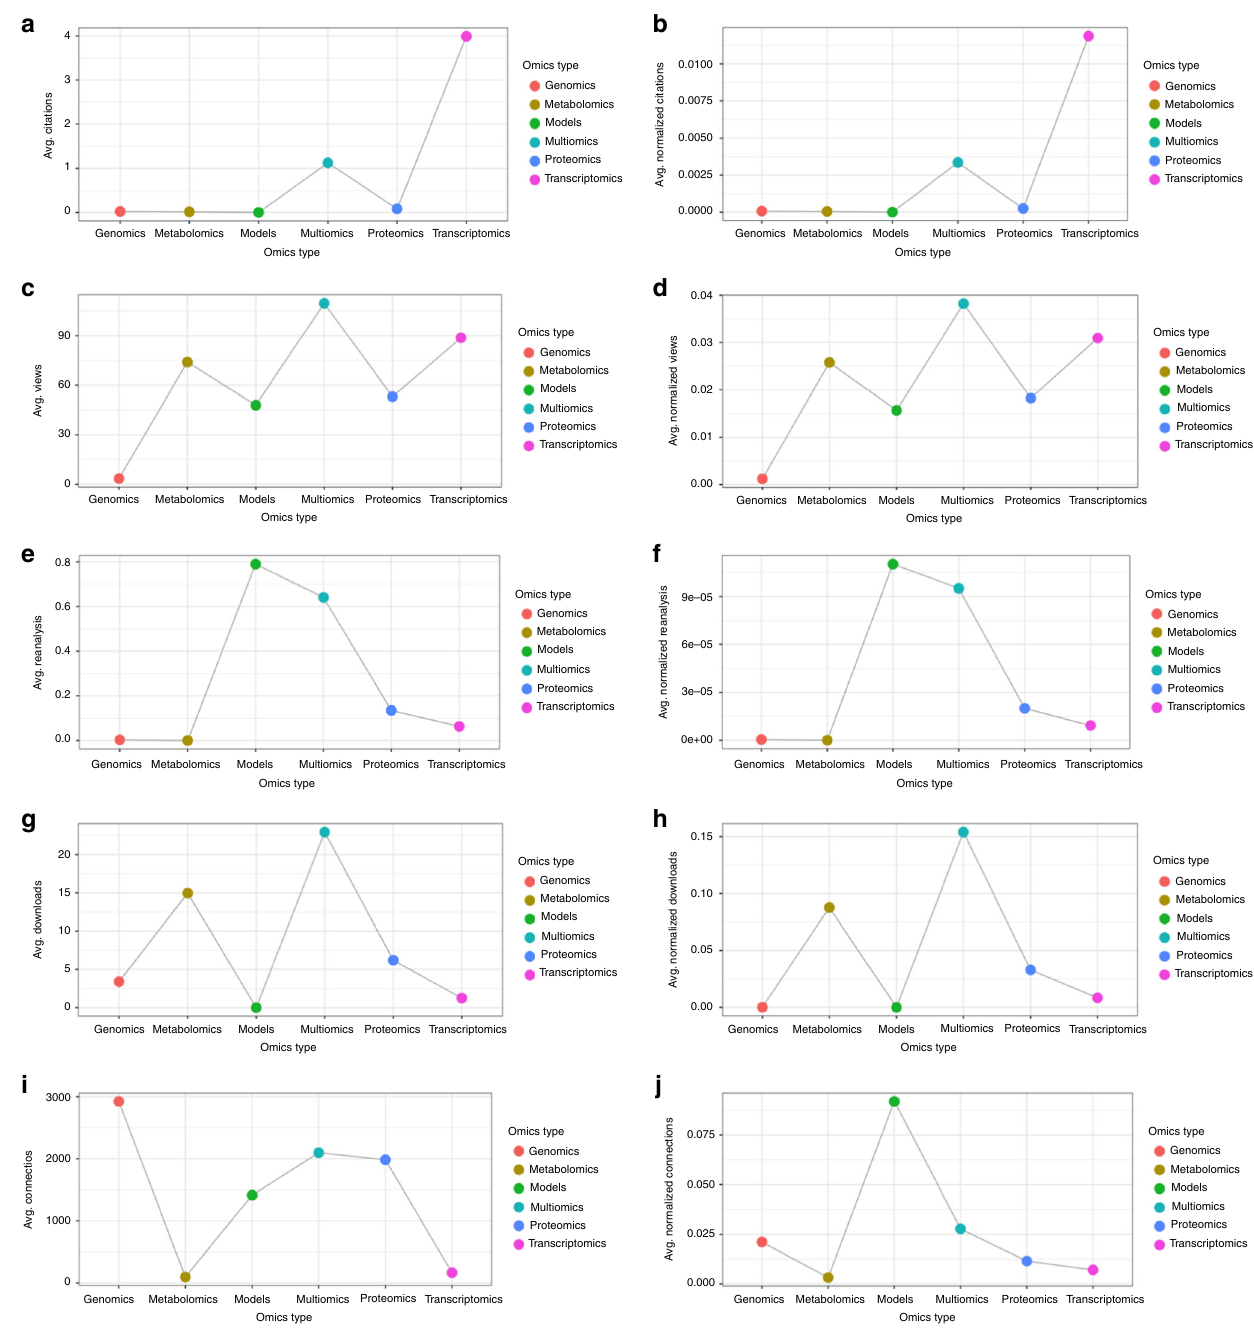
Fig. 4 Average distribution of each metric ( citations, views, reanalysis, downloads and connections ) by omics type: raw ( a , c , e , g , i ) and normalised values ( b , d , f , h , j ). The raw values are the metrics values collected with the OmicsDI pipelines, whereas the normalised values are the transformation of those values using MinMax scaler or the Biological connections normalisation method (e.g. PLOS https://www.plos.org/article-level-metrics) to complement the 2. Direct citations of dataset identi fi ers in publications (citations) : Citations number of manuscript citations. By 2019, we were able to systematically trace represent the number of publications that directly refer to dataset identi fi ers 14 . the number of direct downloads from six different data resources (PRIDE, We use the EuropePMC API (europepmc.org/RestfulWebService) 33 to query ArrayExpress, MetaboLights, EVA, Expression Atlas and ENA). Additionally, all the open access publications that directly cite a dataset accession. we provide counts of the number of views and accesses for each dataset EuropePMC stores scienti fi c publications (and also pre-prints) that are open coming from all database providers via the OmicsDI web and restful API access, so the whole text of the manuscript can be used for performing text (https://www.omicsdi.org/ws/), respectively. mining, enabling this functionality. With increasing standardisation of data 4. Number of biological entities claims based on the dataset (connections) : Here, citations in the scienti fi c literature, as proposed by Fenner et al. 29 , this metric we provide counts of the number of biological entities which are reported by a is expected to become easier to systematically generate in the future. given dataset, in various popular biomedical knowledge bases, such as UniProt 3. Number of downloads and views (downloads and views) : The number of (protein sequences), IntAct 34 (molecular interaction data) or Reactome 35 views and downloads of each dataset can be used to estimate the number of times a dataset is used even if it does not get cited or publicly reanalysed. (biological pathways) (Fig. 5b), (Supplementary Note 2). Most of the omics These two metrics have recently been proposed by different journals datasets support biological claims (e.g. pathways, interactions, expression NATURE COMMUNICATIONS| (2019) 10:3512